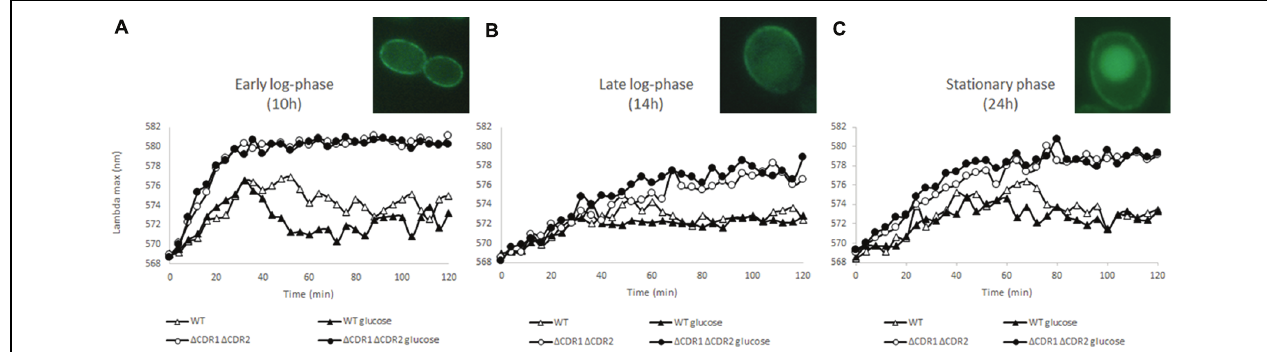
FIGURE 1 | DiS-C3(3) fluorescence staining of wild-type and CDR1 (cid:2) CDR2 (cid:2) strains during early log-phase (A), late log-phase (B), and stationary phase (C). 2% glucose was added at the start of the experiment ( n = 3). Pictures: Cdr1-GFP localization during (A–C) .